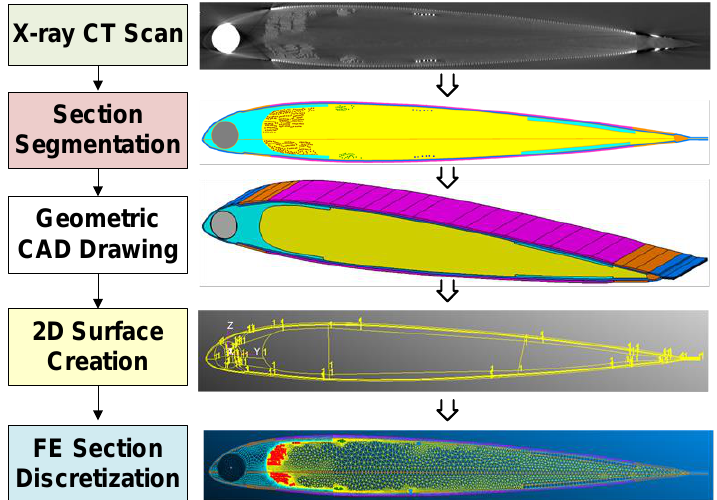
Figure 10. Flow diagram for building the FE blade section analysis model.